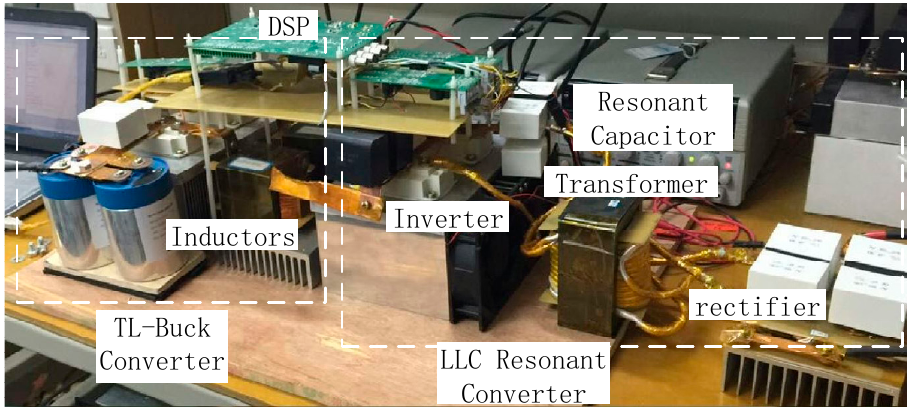
Figure 17. The HFI fast-charging DC port system experimental setup. Table 2. Circuit parameters of the HFI fast-charging DC port system.